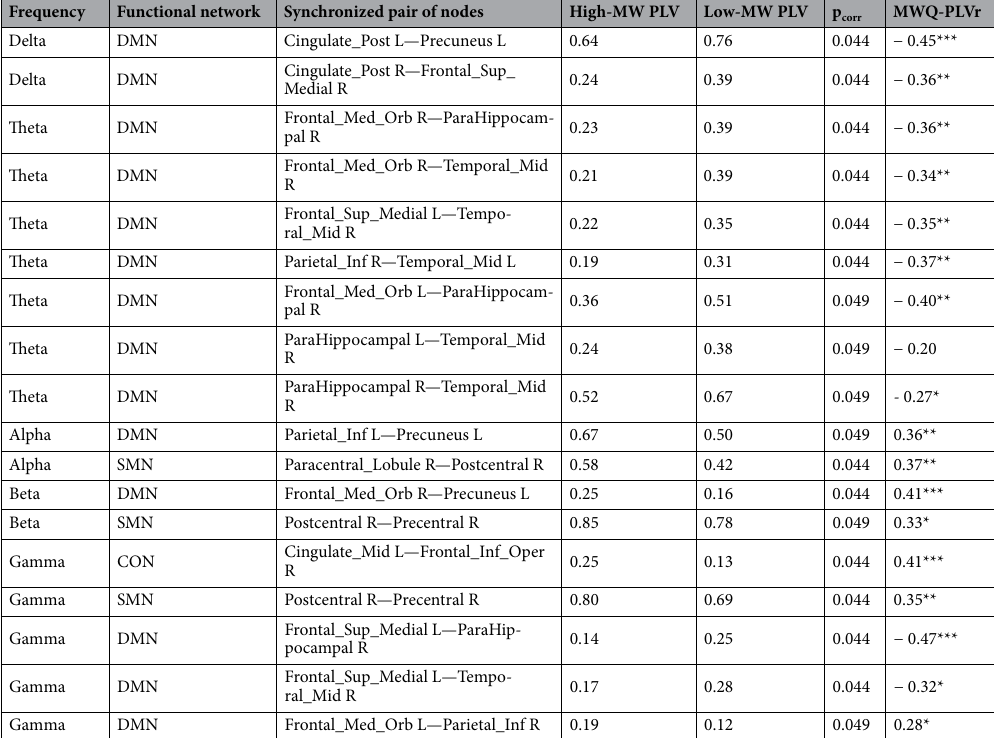
Table 2. Intra-network differences between subpopulations differing with regard to dispositional Mind Wandering and the results of Pearson’s linear correlations (r) between MWQ total score and functional connectivity values measured by the PLV in the whole sample. p corr —permutation test’ level of statistical significance, including FDR correction 23R, 13R. *Correlation significant at p < 0.05. **Correlation significant at p < 0.01. ***Correlation significant at p <